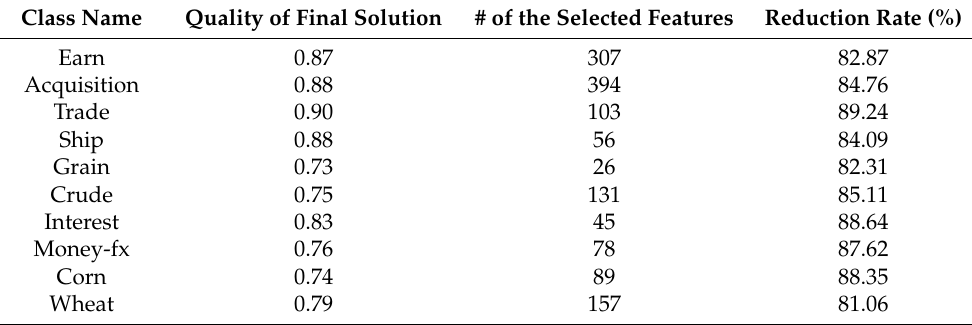
Table 8. Quality of the final solution, number of features and reduction rate of BBA CO in the Reuters dataset.